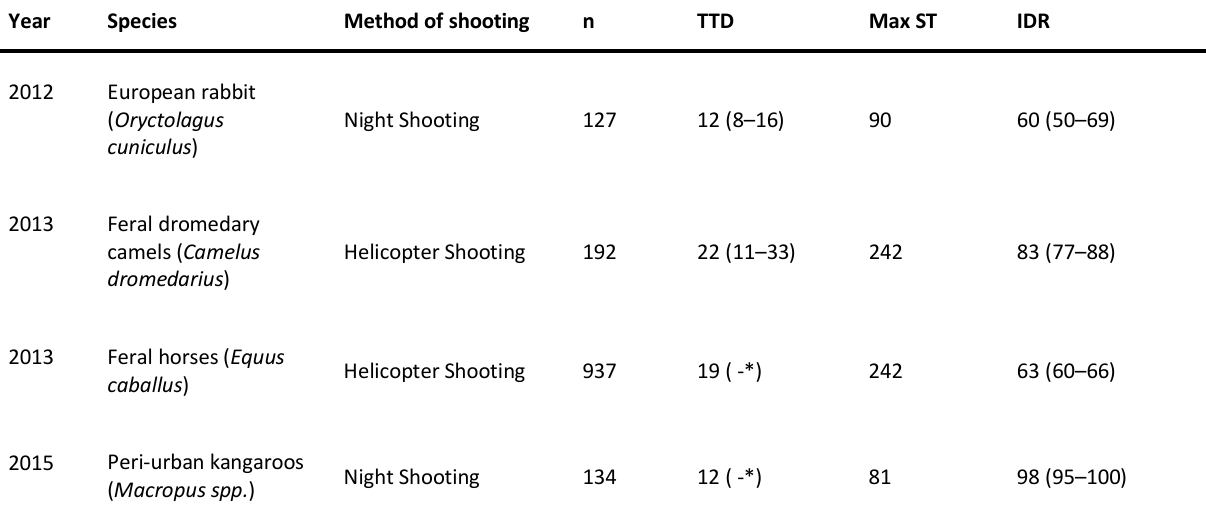
(Table 2), chital deer ( Axis axis ) and fallow deer ( Dama dama ) (Hampton, Bengsen et al., 2021; Hampton et al., 2014, 2017). It also includes night-shooting of European rabbit (Oryctolagus cuniculus ) and peri-urban eastern grey Table 2. Adapted from Hampton et al. (2014, 2015, 2017), and Hampton & Forsyth (2016). Time to death (TTD) in seconds expressed as mean values with 95% confidence interval (CI) (brackets) and maximum survival time (ST), and instantaneous death rate (IDR) in percent with 95% CI for animals subject to lethal control measures. Number of animals assessed (n), and method of shooting stated for each. Helicopter shooting is defined as shooting targets from a helicopter platform with a rifle. Night shooting indicates shooting takes place after dark with a spotlight illuminating the target. *95% Confidence Intervals not